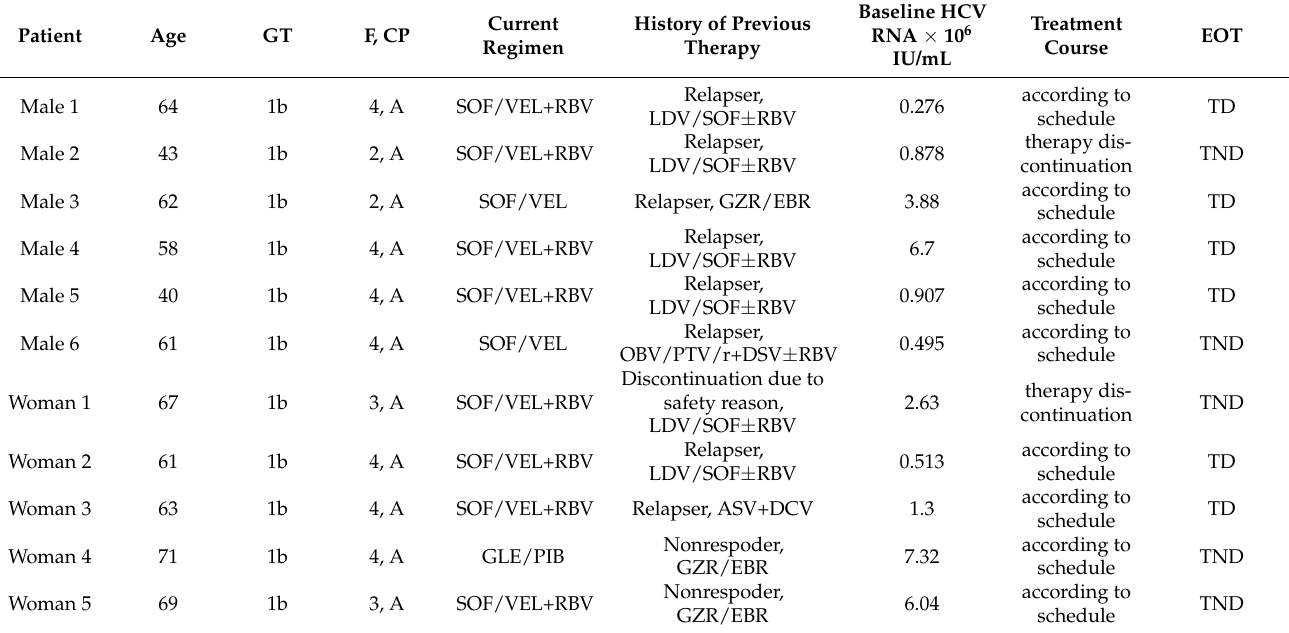
Table 5. Characteristics of 11 Virologic Failures to Treatment.